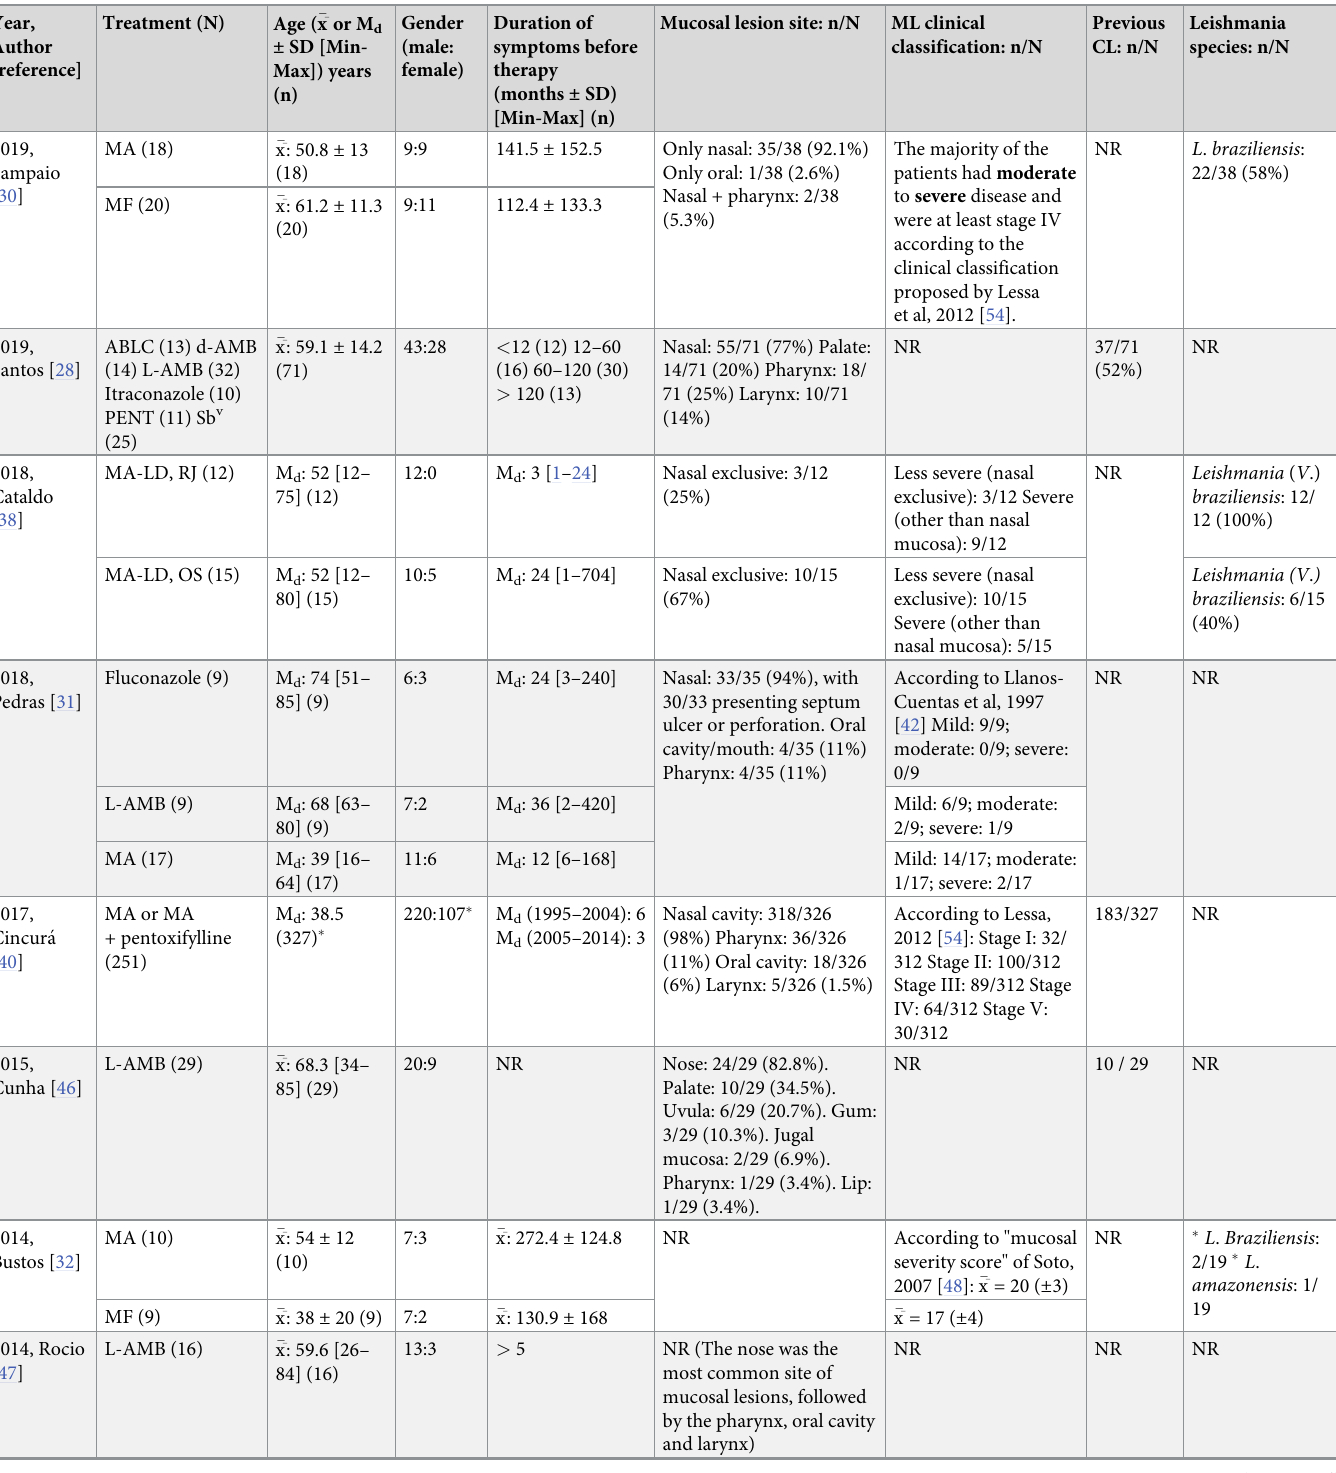
Table 2. Characteristics of the population with mucosal